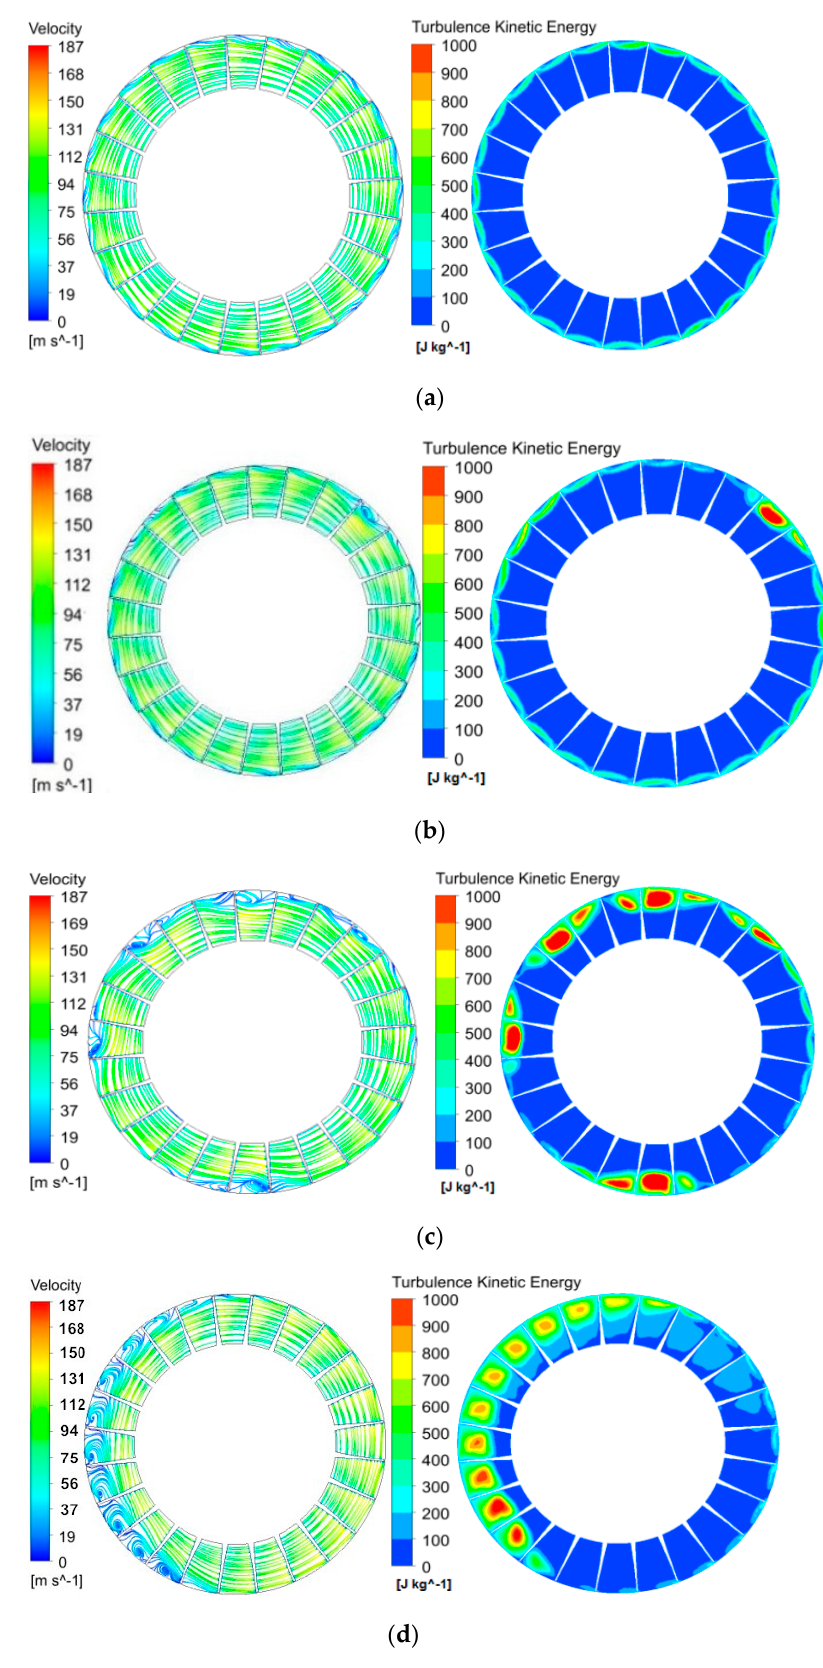
Figure 9. Streamline and the turbulent kinetic energy contour of the second rotor midsection. ( a ) Near stall inception at 11 T , ( b ) stall inception stat at 12 T , ( c ) development of stall inception at 15 T , and ( d ) complete stall cell at 18 T .